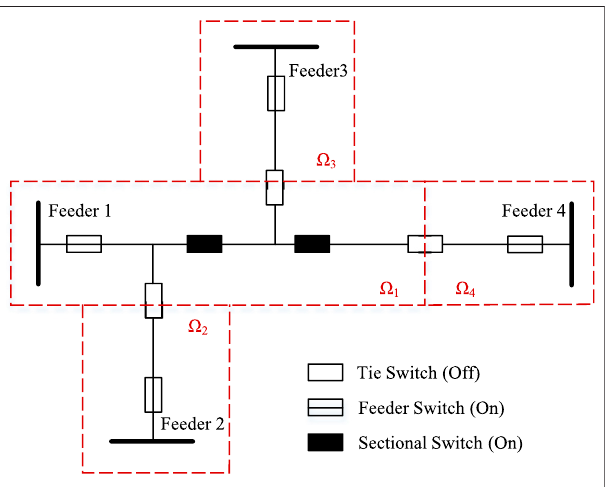
FIGURE 2 | Schematic diagram of the distribution network